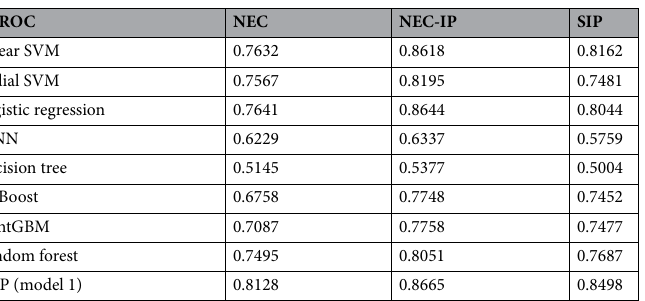
Table 2. Model performance of classic ML models for predicting NEC, NEC-IP, and SIP. ML machine learning, NEC necrotizing enterocolitis, NEC-IP intestinal perforation associated with necrotizing enterocolitis, SIP spontaneous intestinal perforation, SVM support vector machine, K-NN k-nearest neighbor, XGBoost extreme gradient boosting, GBM gradient boosting machine learning , LightGBM light gradient boosting machine learning, MLP multilayer